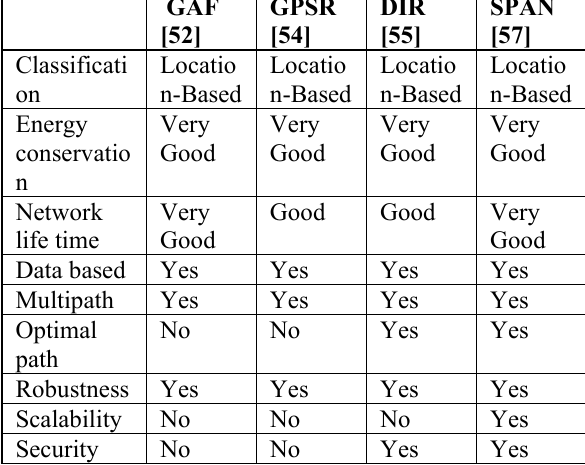
Table 4. Performance Comparison of